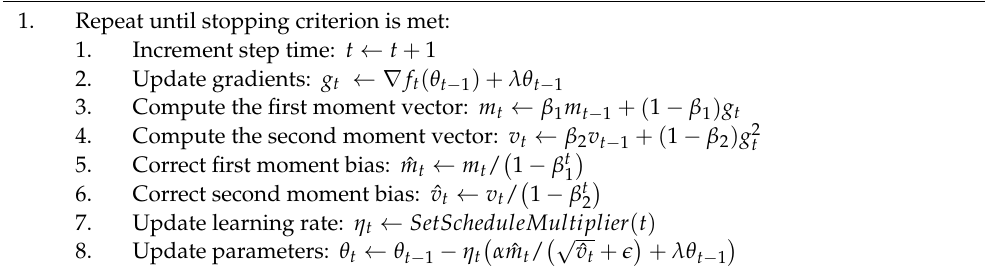
Algorithm 1: Pseudocode Adapted from [1,54]. The Code Written in Red is Used only by Adam with L2 Regularization, While the One Written in Green Is only for AdamW.